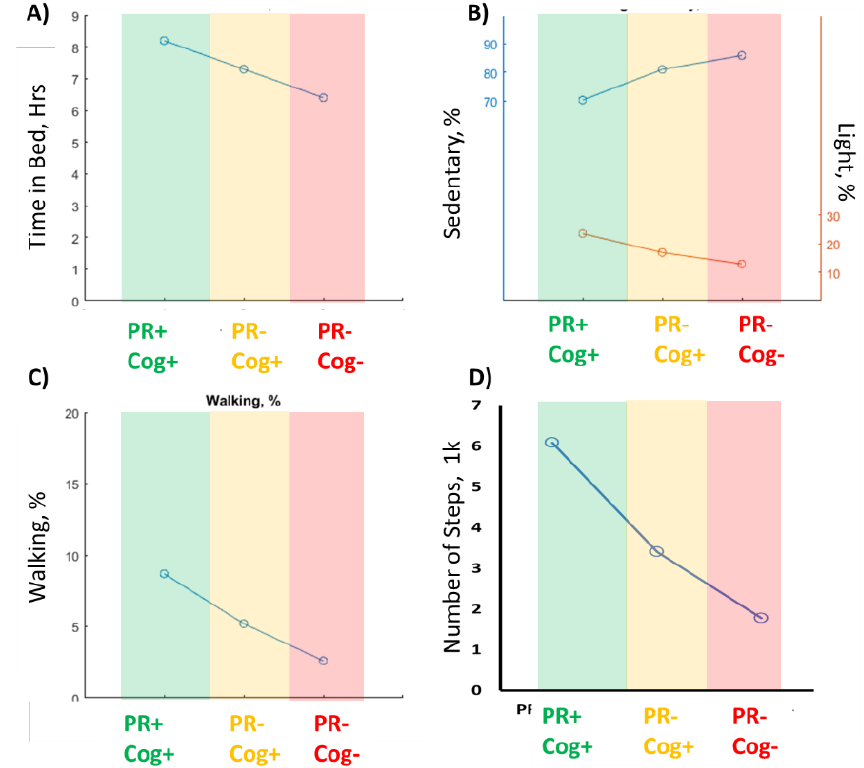
Figure 3. The top 4 sensor-derived parameters to identify the cognitive frailty group (PR-Cog-) from other groups. ( A ) the time in bed declined from robust group (PR + Cog + ) to cognitive frailty group. ( B ) The percentage of sedentary duration increased while light activity reduced from Robust to cognitive frailty group. ( C ) the percentage of walking duration declined from Robust group to cognitive frailty group. ( D ) The number of steps reduced from robust group to cognitive frailty group.